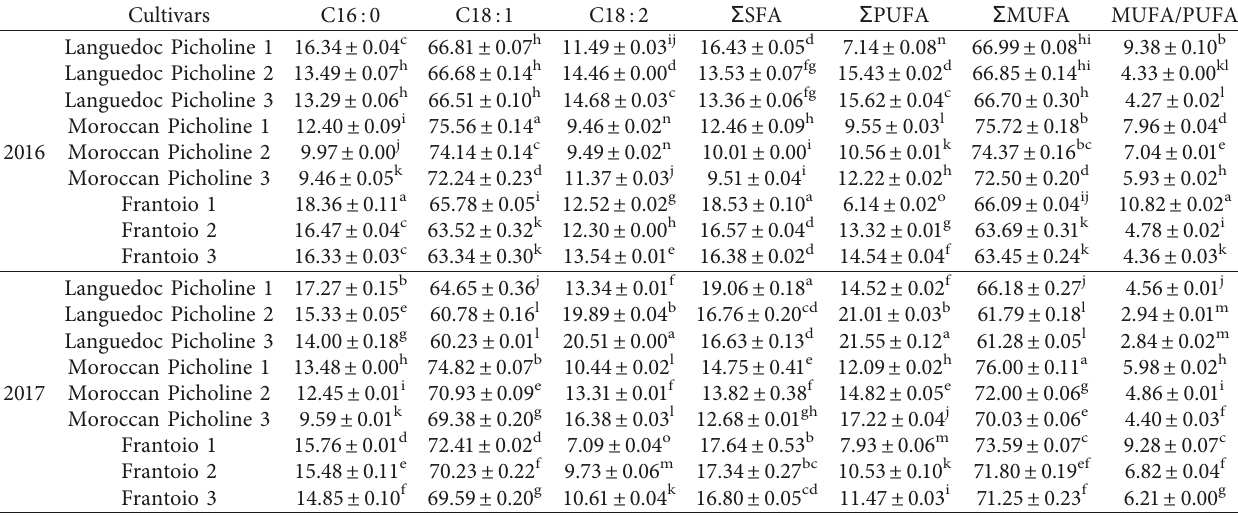
Table 5: Fatty acid composition (%) of the virgin olive oils of three cultivars grown in Errachidia (East Morocco) during the two crop seasons (2016 and 2017).